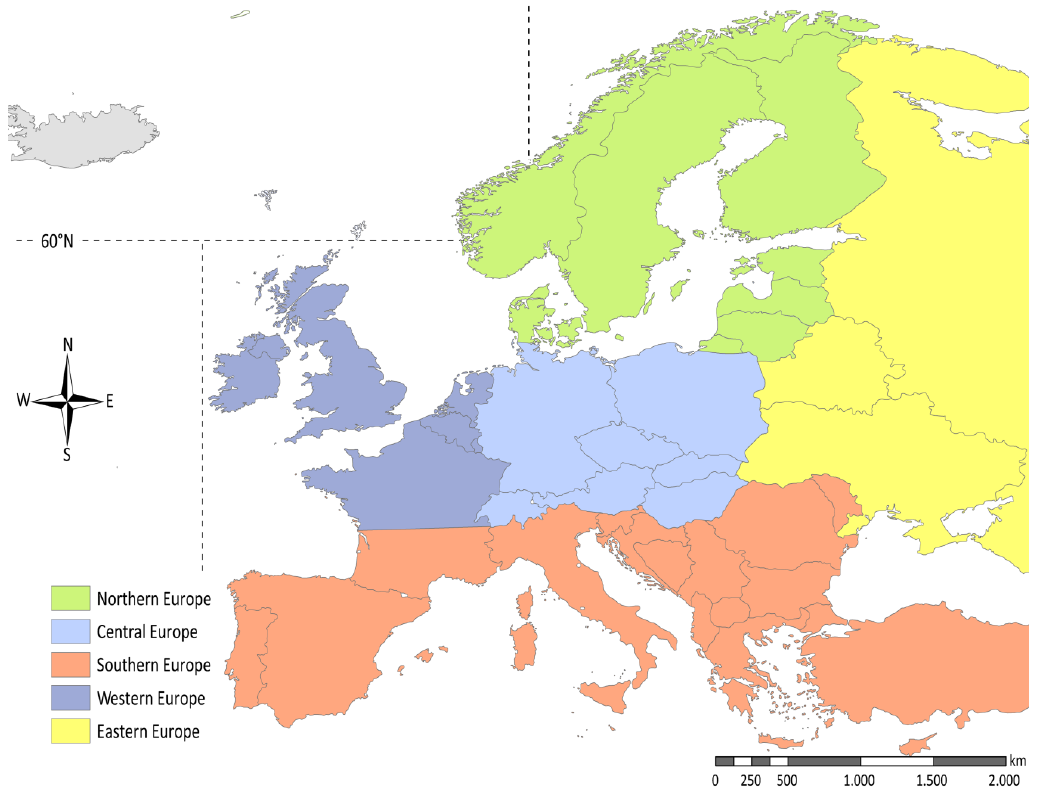
Figure 1. Differentiation of the study area (North Atlantic European region: NAER) into seven subregions. The horizontal dashed line at 60°N divides the North Atlantic into the subregions North Atlantic north of 60°N and North Atlantic south of 60°N. The vertical dashed lines indicate the eastern boundaries of the two North Atlantic subregions.